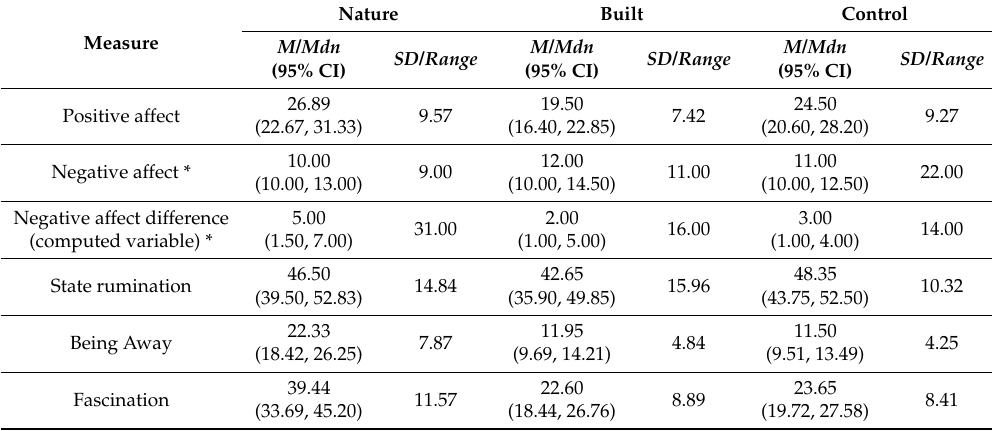
Table 5. Descriptive Statistics at Post-Manipulation by Condition.